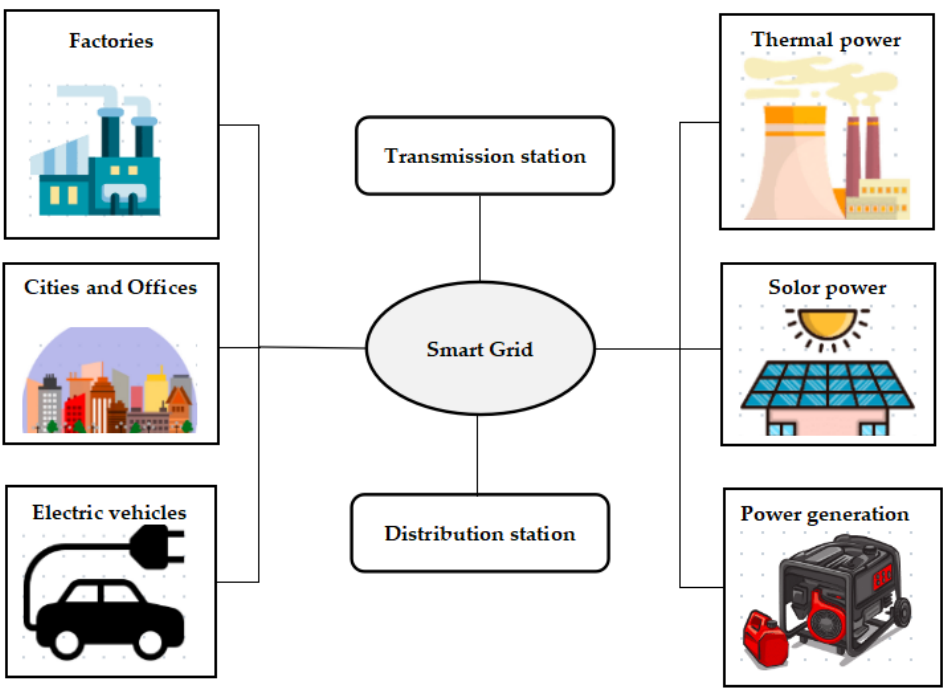
Figure 11. Innovative grid development is impacted by several important factors [119].